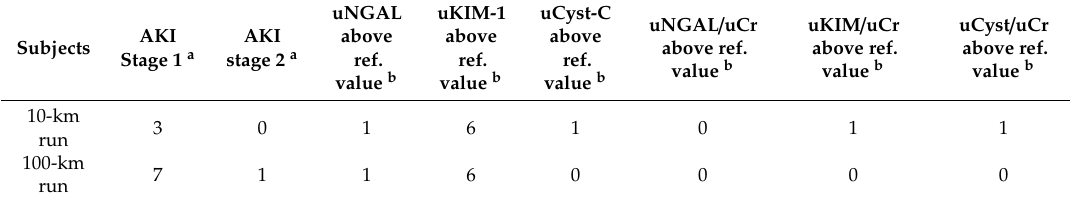
Table 7. Number of runners with values typical for